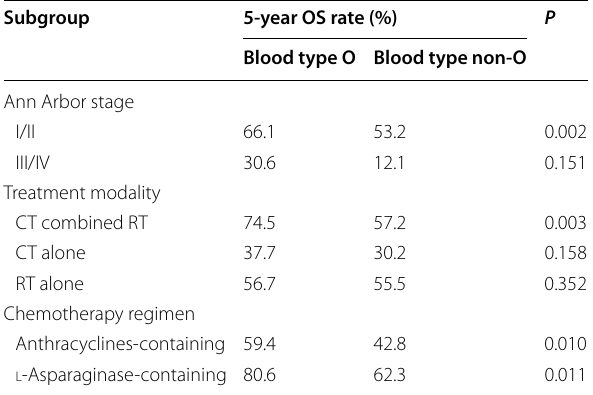
Table 3 The prognostic significance of ABO blood type in different subgroups of ENKTL patients